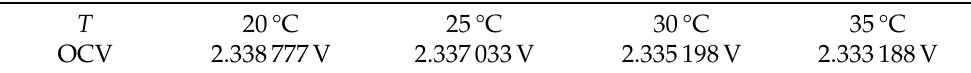
Figure 6. EHC calculated from the fitted coefficient ( ∆ S / n · F ) T including the 95% confidence bound over the SoC range (red) in comparison with the simpler approach of averaging the low current measurements according to Equation (24). Table 4. Open circuit voltage measured as a function of cell temperature at 65% SoC for verifica- tion